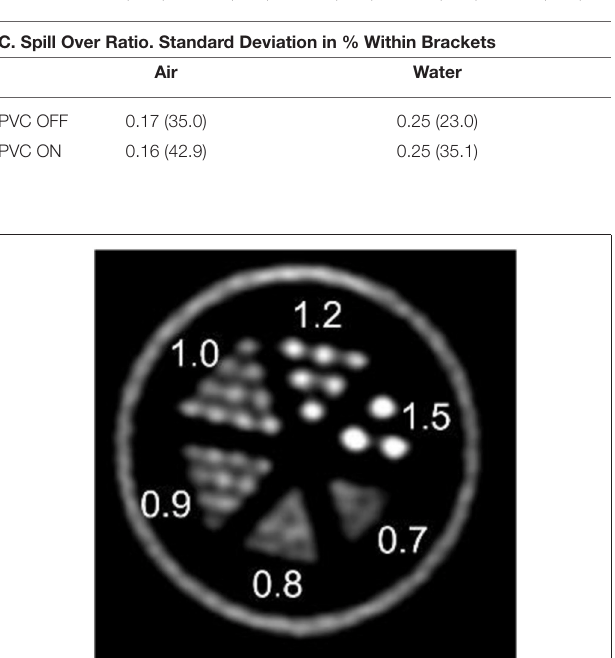
FIGURE 6 | micro-Derenzo phantom imaged for 20min with 3 MBq of [ 18 F]-FDG. Capillary sizes in mm are shown in the